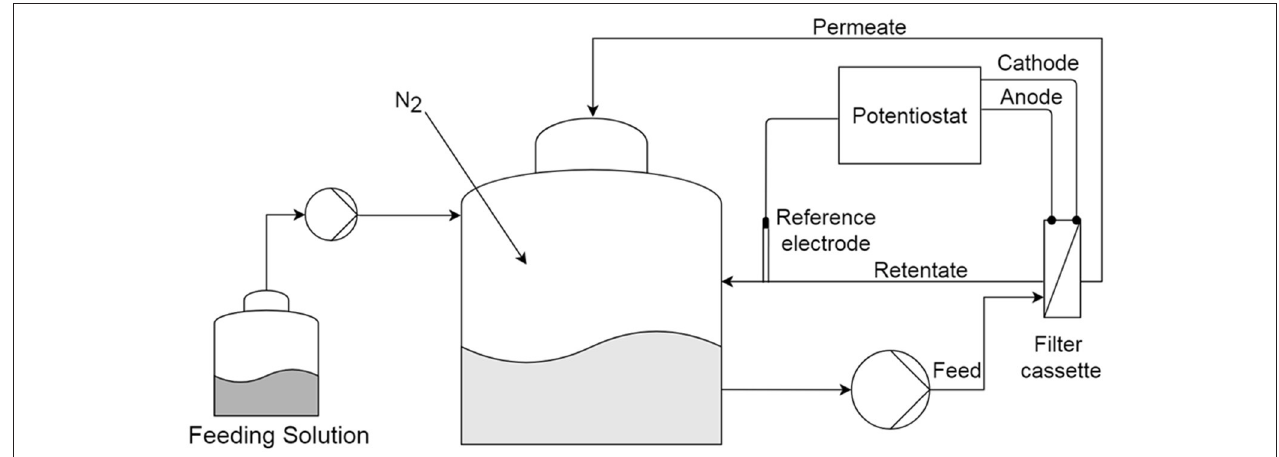
FIGURE 1 | Experimental setup for the microbial anode integrated into an anaerobic membrane bioreactor.